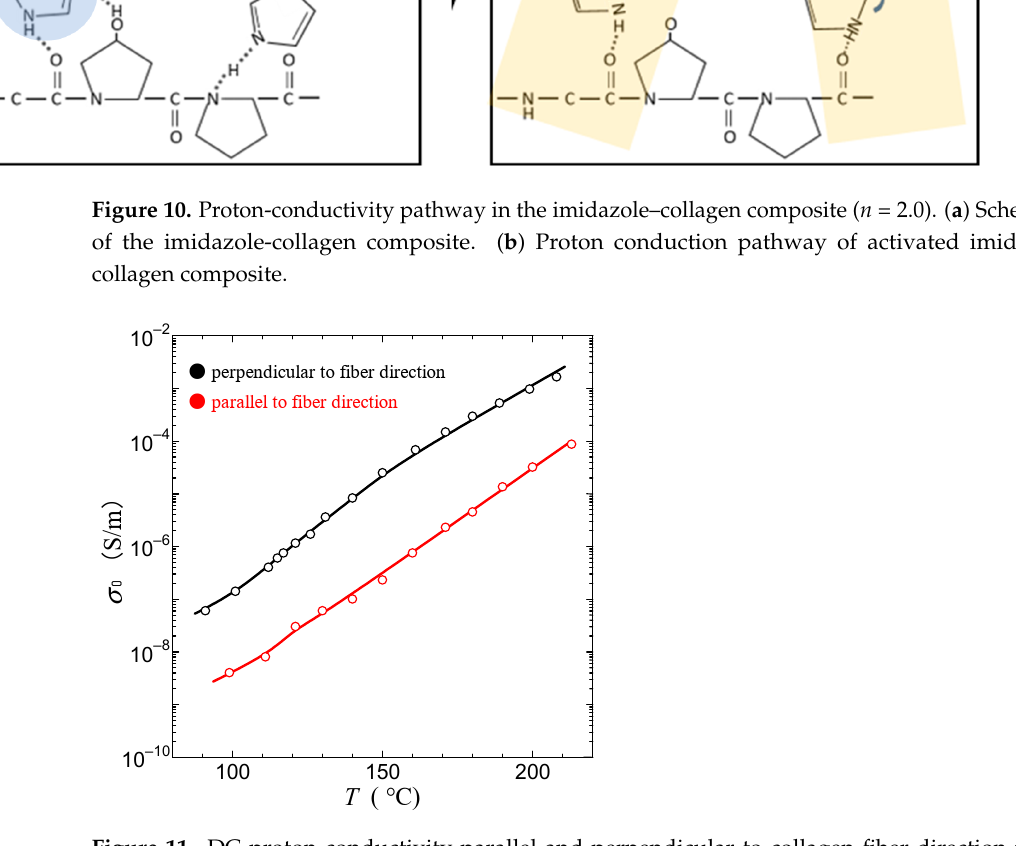
Figure 11. DC proton conductivity parallel and perpendicular to collagen fiber direction in the imidazole–collagen composite film.